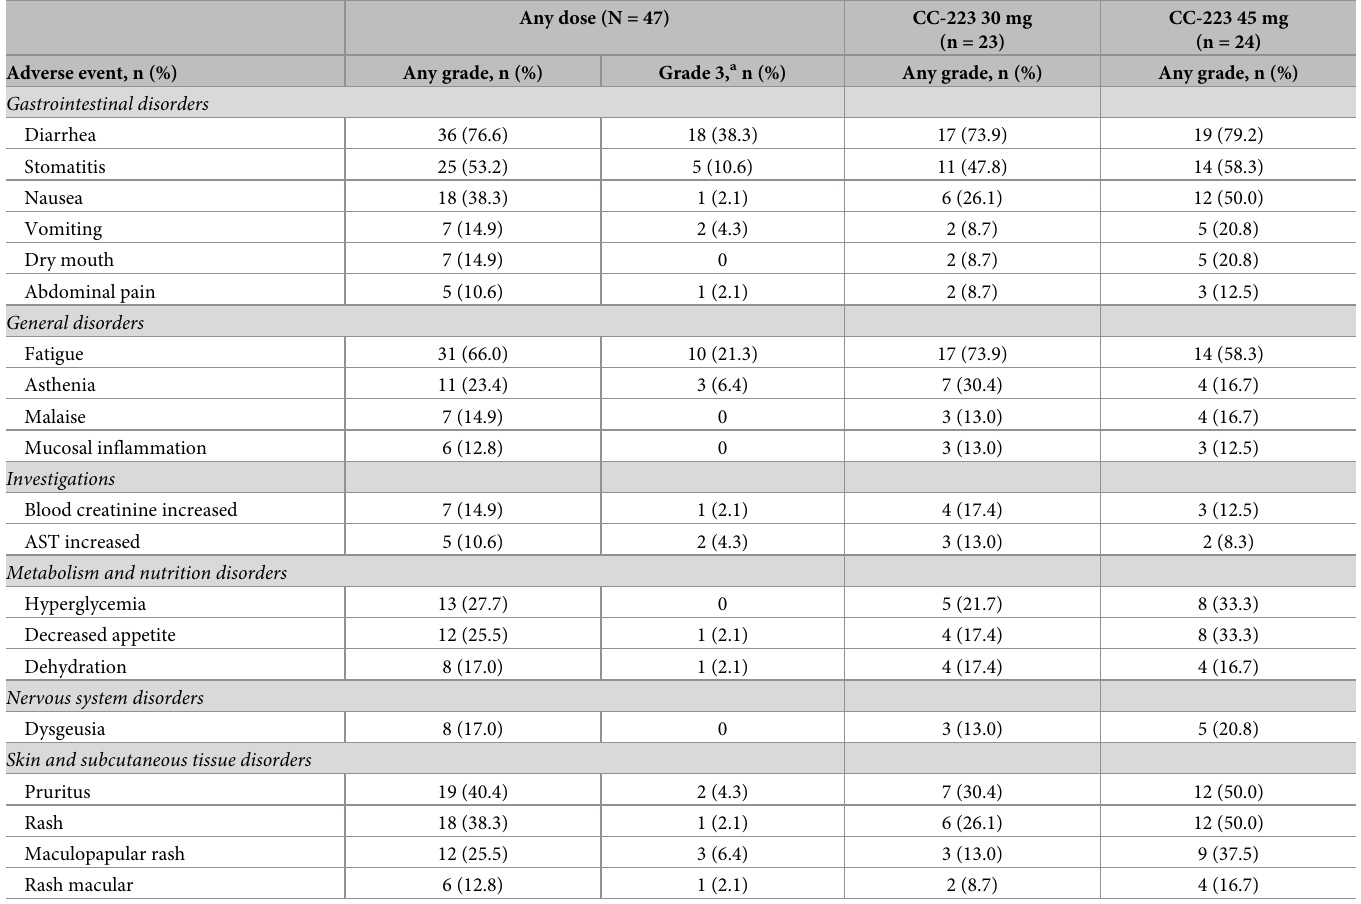
Table 2. Most common treatment-related adverse events in � 10% of patients (n =